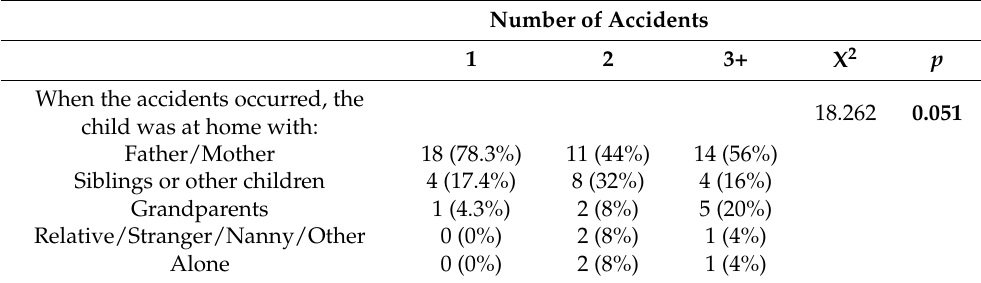
Table 5. Factors related to the number of child accidents.